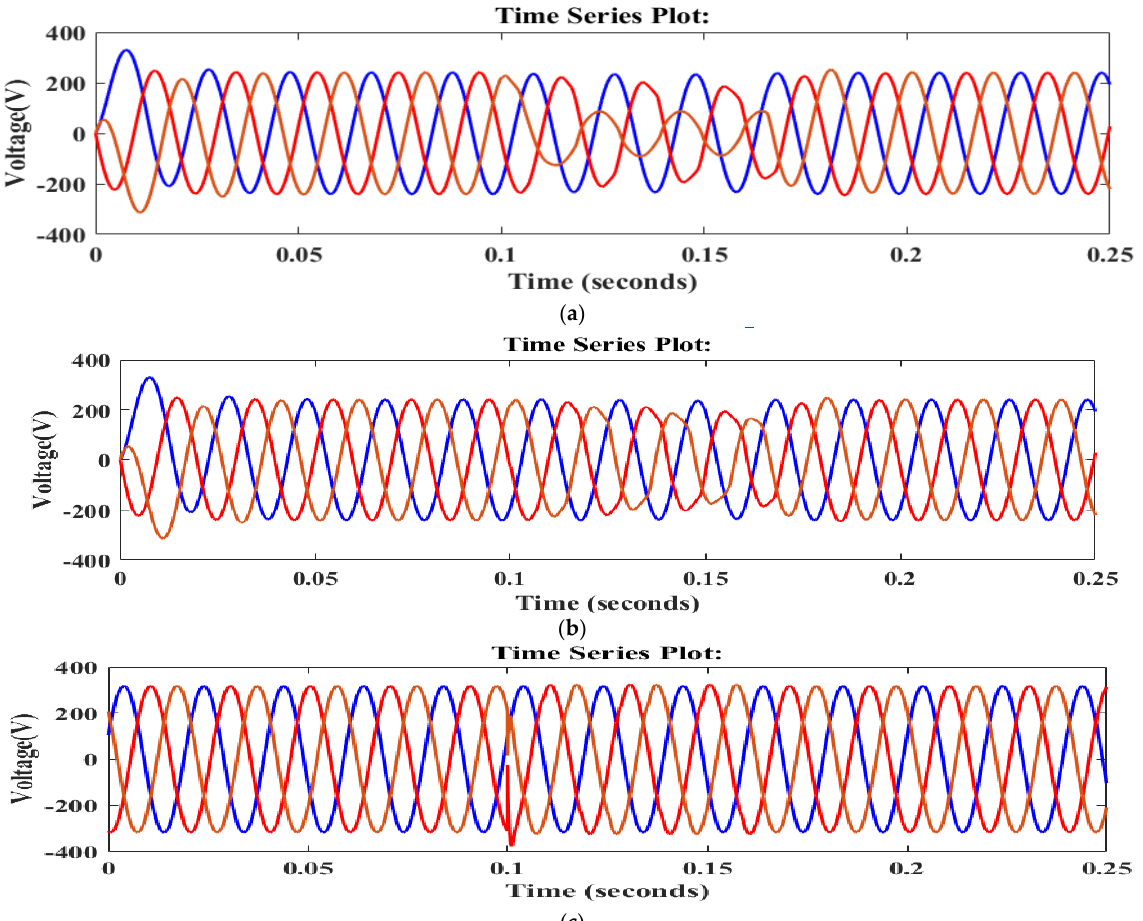
Figure 14. ( a ). MG operation through unbalanced condition: PID controller. ( b ) MG operation during unbalanced condition: fuzzy-PID controller. ( c ) MG operation during unbalanced condition: NARX controller.